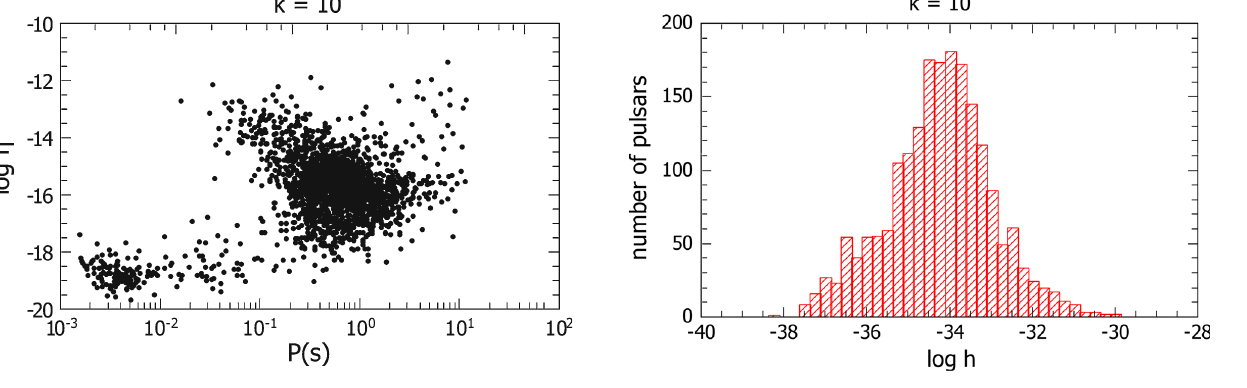
is equivalent to the ratio h / h SD , i.e., the spin-down ratio. One